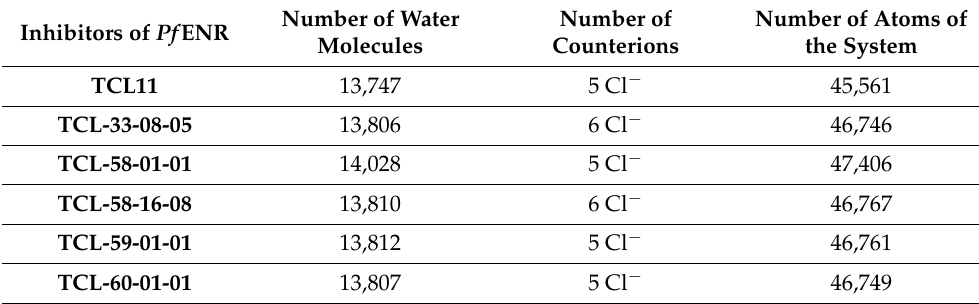
Table 9. Molecular dynamics system